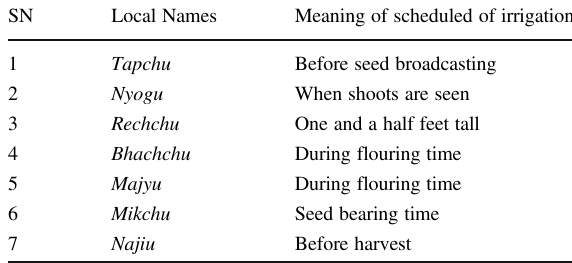
of irrigation in Lo-mathang